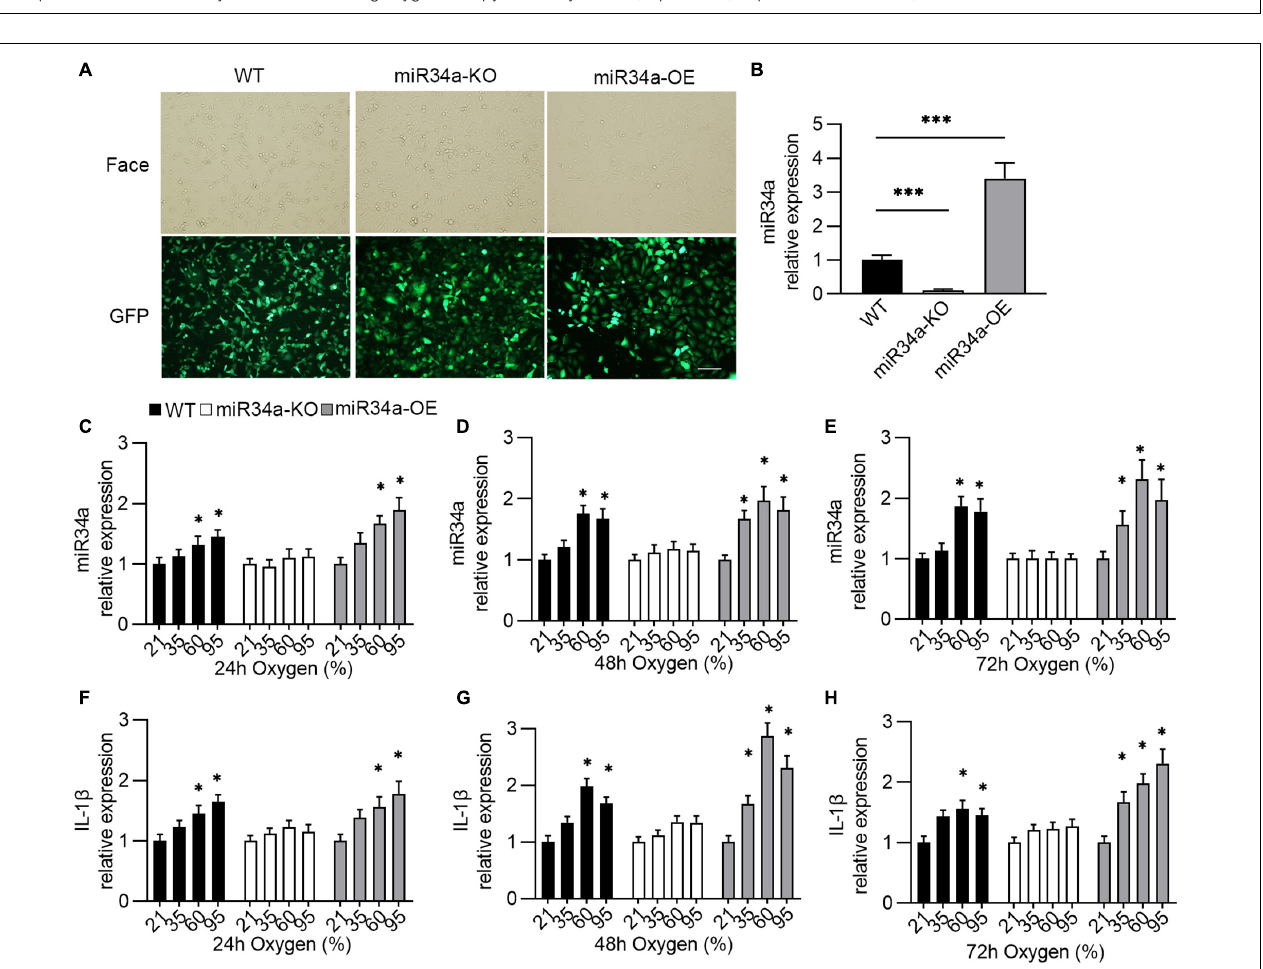
FIGURE 2 | Establishment of oxygen-injury A549 cell model. (A,B) A549 cell that overexpression or knockdown of miR34a was established by being infected with lentivirus that carrying miR34a sequence or miR34a shRNA and their mRNA level (B) . One-way ANOVA, ∗∗∗ p < 0.001 vs. WT, n = 5. Transfected cells images under the light (Face) and fluorescence (GFP) microscope. (C–E) The expression of miR34a was detected by qPCR after exposure to oxygen. (F–H) The expression of IL-1 β was assayed using ELISA after exposure to oxygen. One-way ANOVA, ∗ p < 0.05, ∗∗∗ p < 0.001 vs. 21%, n = 5.